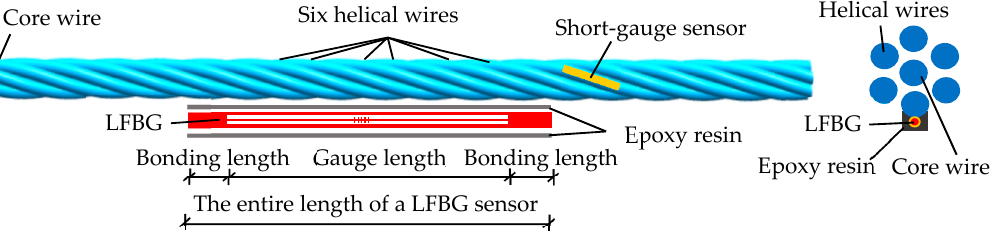
Figure 2. Comparison of gauge length between LFBG sensor and the short-gauge sensor.